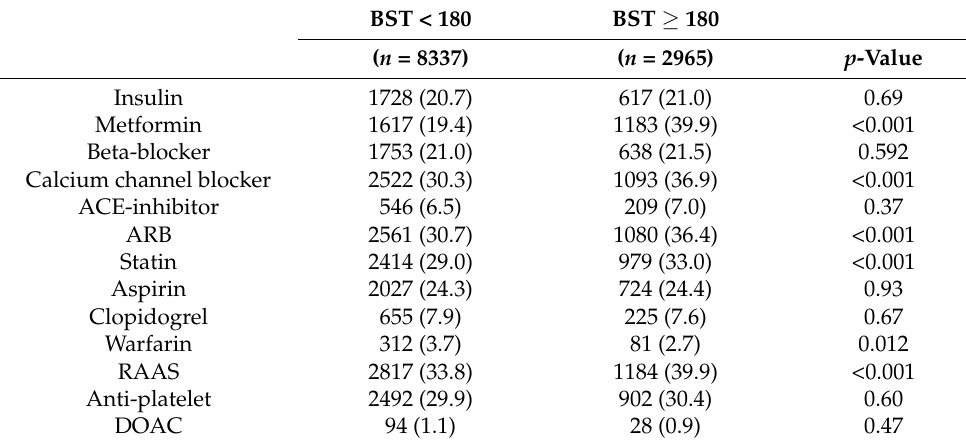
Table 2. Preoperative medical